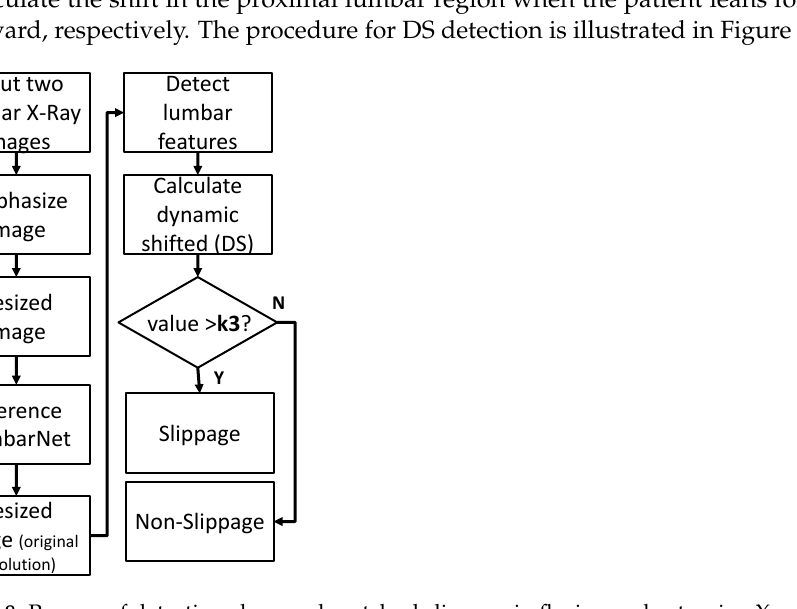
Figure 8. Process of detecting abnormal vertebral slippage in flexion and extension X-ray images by using dynamic shift